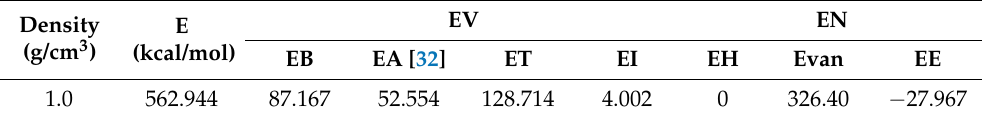
Table 7. Energy of the coal sample from